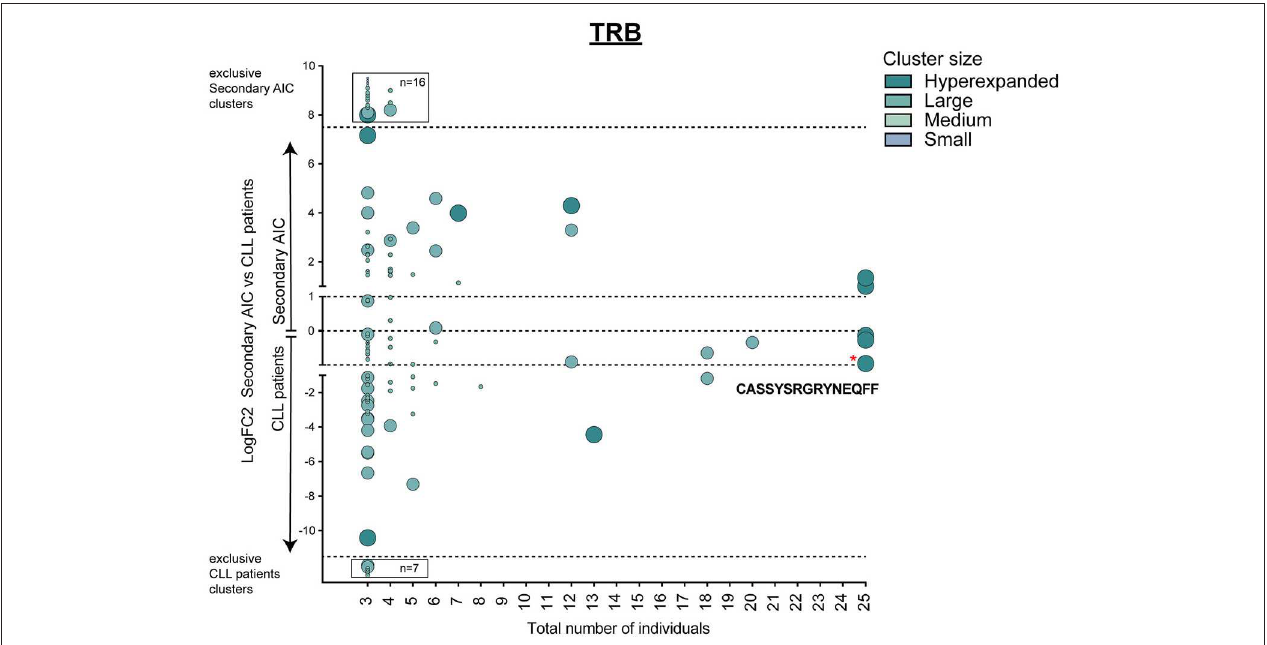
FIGURE 5 | Cluster analysis of lymphoma-associated TRB repertoires. Logarithmic fold-change of clusters that were present in at least 3 individuals in patients with secondary AIC vs. patients with CLL. Cluster size and color represents mean frequency of CDR3 clones that constitute the respective cluster. Cluster sizes are defined as hyperexpanded (0.01 < x ≤ 1), large (0.001 < x ≤ 0.01), medium (1E-04 < x ≤ 0.001), small (1E-05 < x ≤ 1E-04). Significantly different abundant cluster were marked with *and their respective cluster sequence. Statistical test: Wilcoxon-rank test. * p ≤